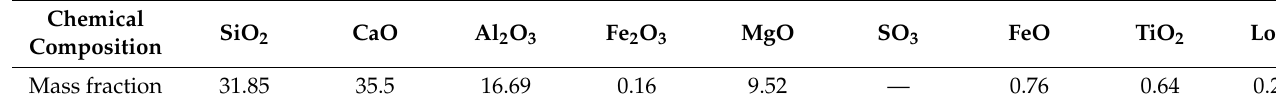
Table 1. Chemical composition of GGBS (wt%).